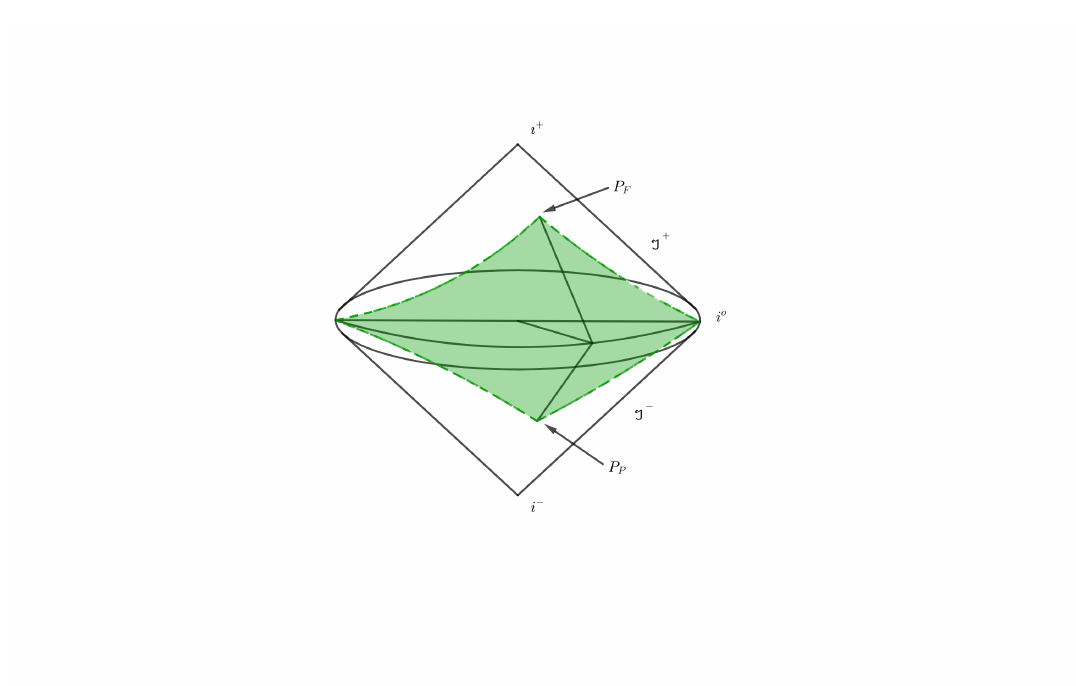
Figure 5: The shaded region is the “back side” of the asymptotic causal diamond, the region on the Minkowski diamond bounded by the boundary of this region is the “front" which we have not marked as to not clutter the figure. The inner curve connecting diametrically opposite points is a straight line (spacelike geodesic) in Minkoswki space. The region between this curve and the “lower”semi-circle is the interior of the ACD. As the vertices of the ACD move closer to the equator of the conformal diagram, the inner curve gets closer to the boundary. The curves in the figure are schematic, their connectivity is what we wish to